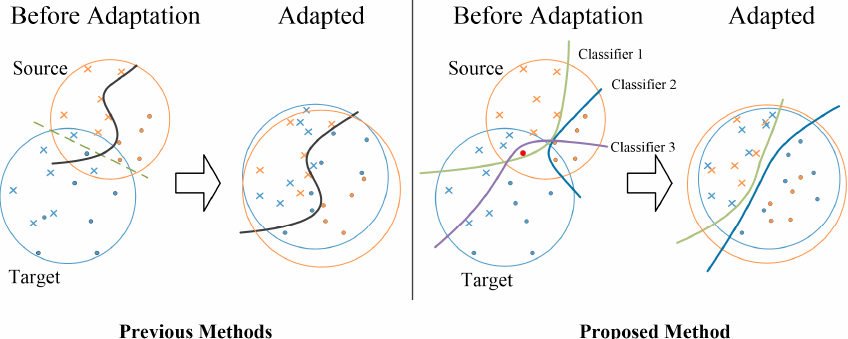
Figure 1. Comparison of previous adversarial methods and the proposed method. In previous methods, some target samples cannot be distinguished correctly (some cross signs and dots are classified into the incorrect side); In the proposed method, the error-correcting boundaries mechanism can redress the incorrect distinction (red dot) by target-domain-specific boundaries. Namely, classifier 1 and classifier 2 both distinguish it into an incorrect class, but classifier 3 can make error-correcting to redress it.